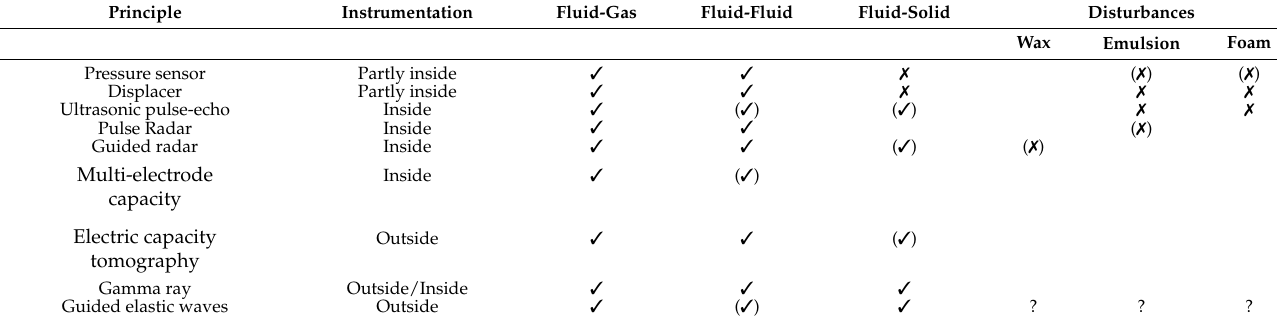
Table 1. Basic available continuous level measurement techniques with the ability to resolve a phase transition (cid:51) , partly resolve it under certain circumstances ( (cid:51) ) or with the inability to resolve it (cid:55) . Additional conditions as wax, emulsion or foam can disturb (cid:55) or partly disturb ( (cid:55) ) the estimation of the specific phase transition. In case of guided elastic waves the ? marks the unavailable experience with additional conditions together with the partial design of the experiment in this work.